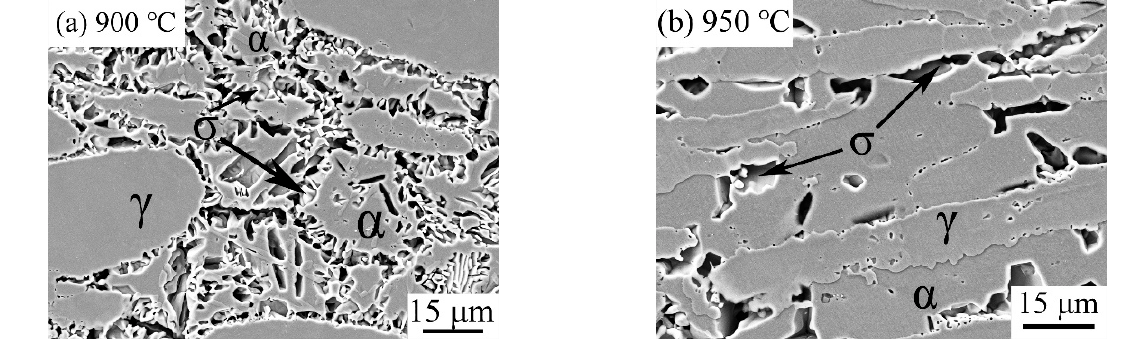
Figure 8. Scanning electron microscopy (SEM) micrograph of σ phase. ( a ) 900 ◦ C; ( b ) 950 ◦ C.